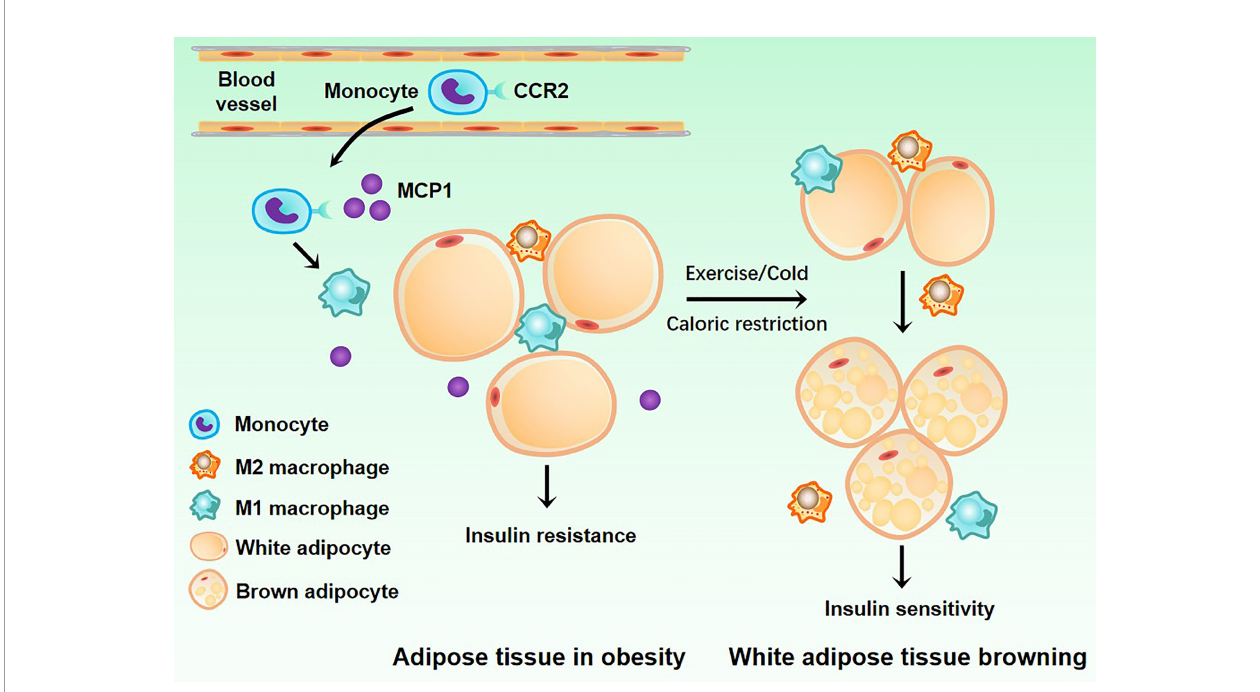
FIGURE 3 | Related mechanisms of adipose tissue macrophages and type2 diabetes mellitus. White adipose tissue acquires insulin resistance under the action of M1 macrophages. When the body is exercising or dieting, M2 macrophages can induce the transformation of white adipose tissue into brown adipose tissue, allowing it to regain insulin